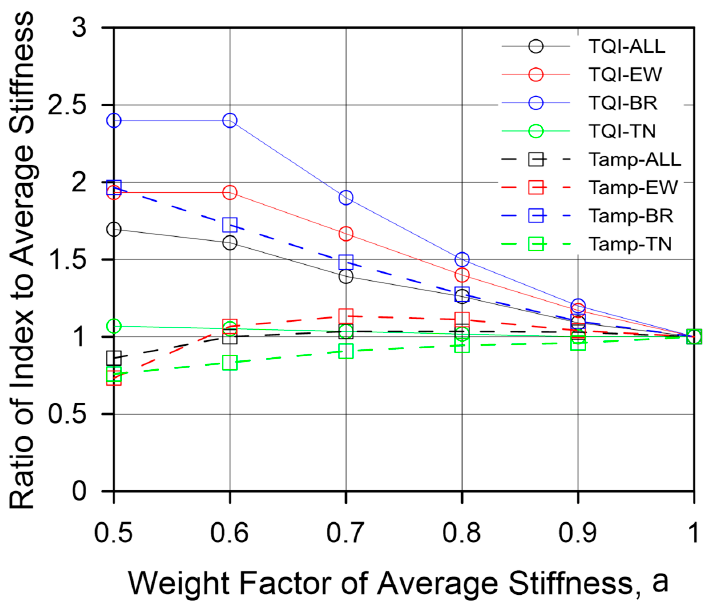
Figure 7. Ratio of the stiffness index to average stiffness according to α .